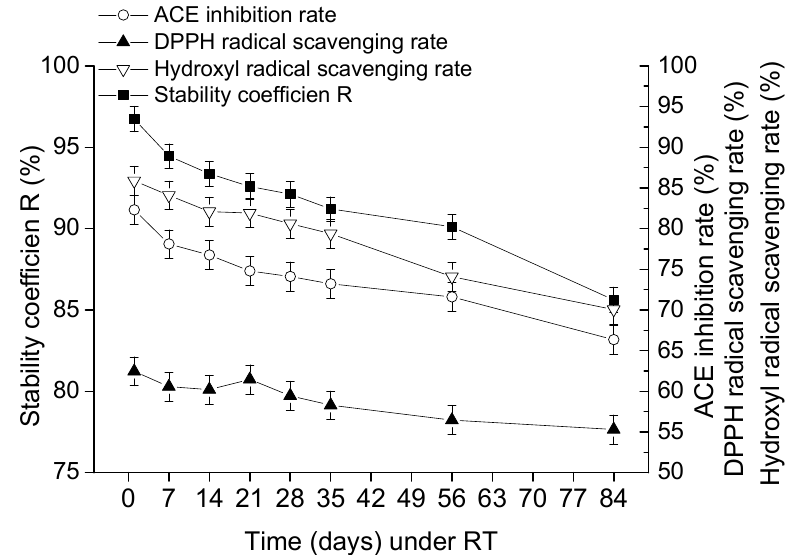
Figure 7. The storage stability, ACE-inhibitory activity, and antioxidant activity in goat milk catalyzed by CEP of L. plantarum LP69 at RT. The error bars represent standard deviation of means ( n = 3).